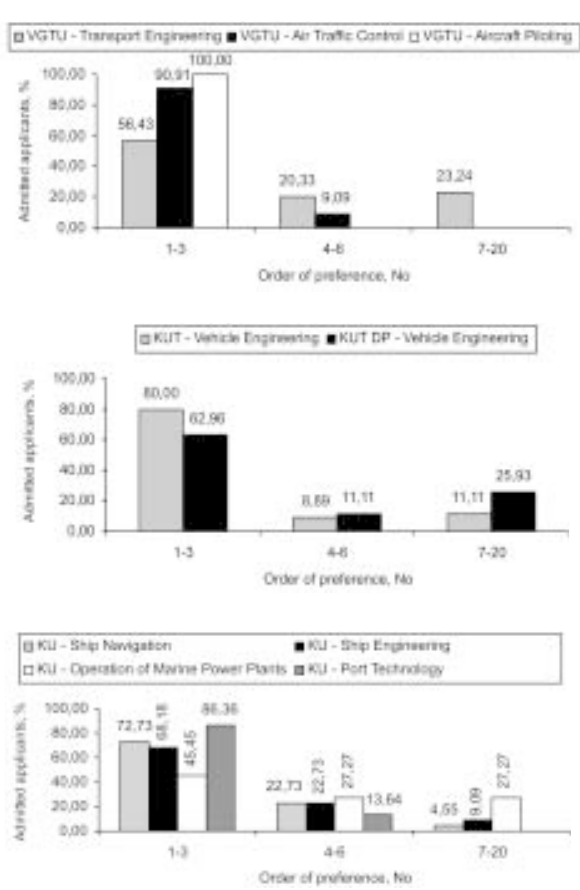
Fig 12. Distribution of the applicants admitted to study the courses in transport engineering according to the preference order of a course of studies in their applications